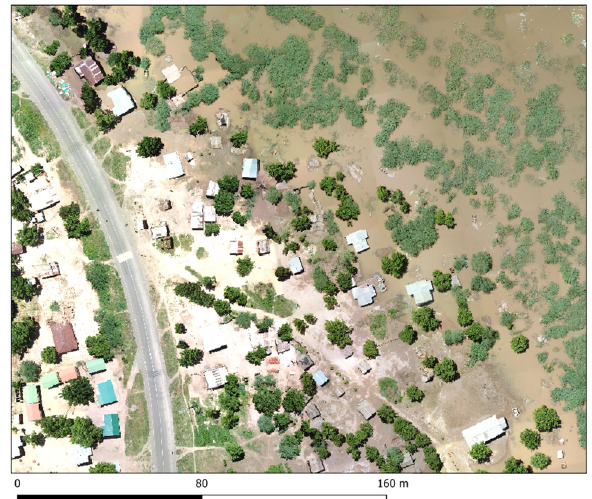
Figure 12. post-event UAV orthophoto of Bangula (UNICEF